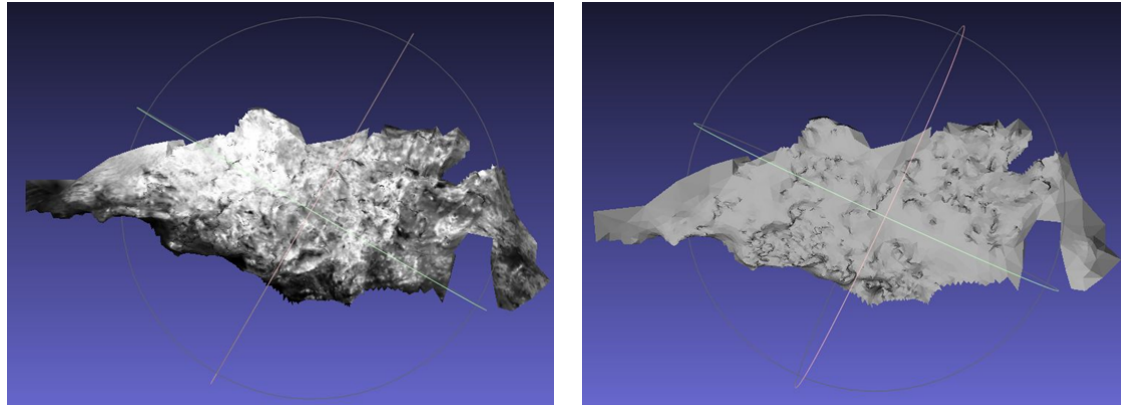
Figure 12. Mesh before element reduction (left) and after element and texture reduction